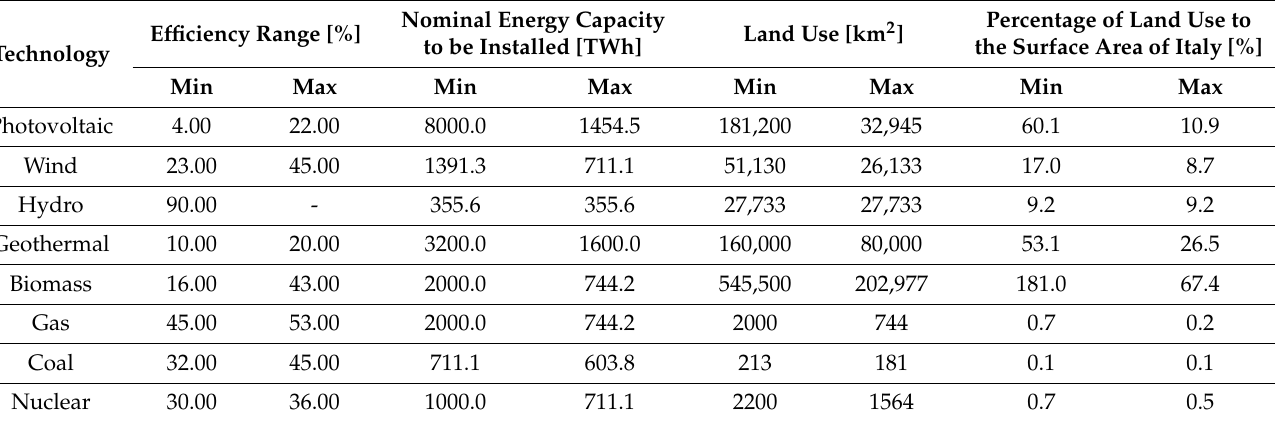
Table 14. Gross energy to be produced (columns 4 – 5) for the net energy requirement of 320 TWh and land use simulation for this energy production (columns 6 – 9) — Efficiency values from Table 13.